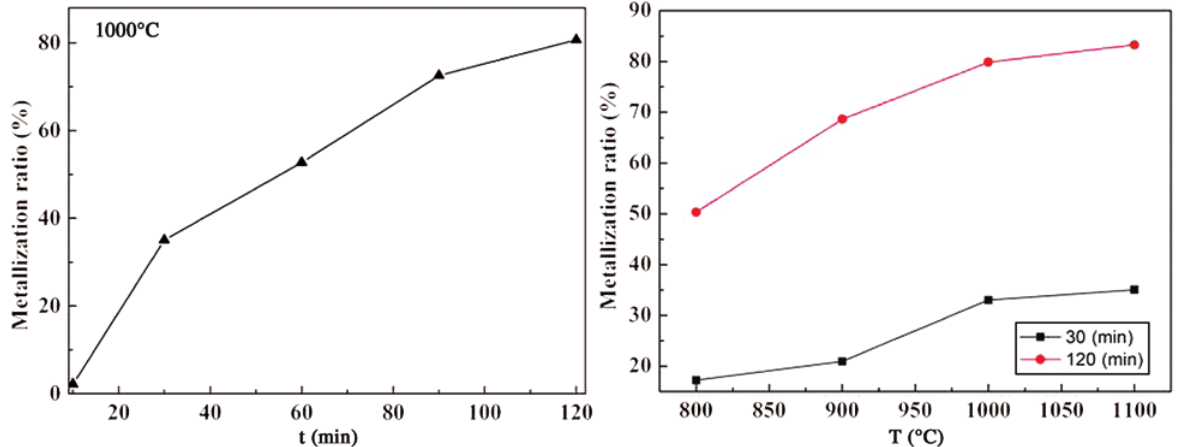
Figure 4: Effect of reduction time or temperature on the metallization ratio of the reduced samples.